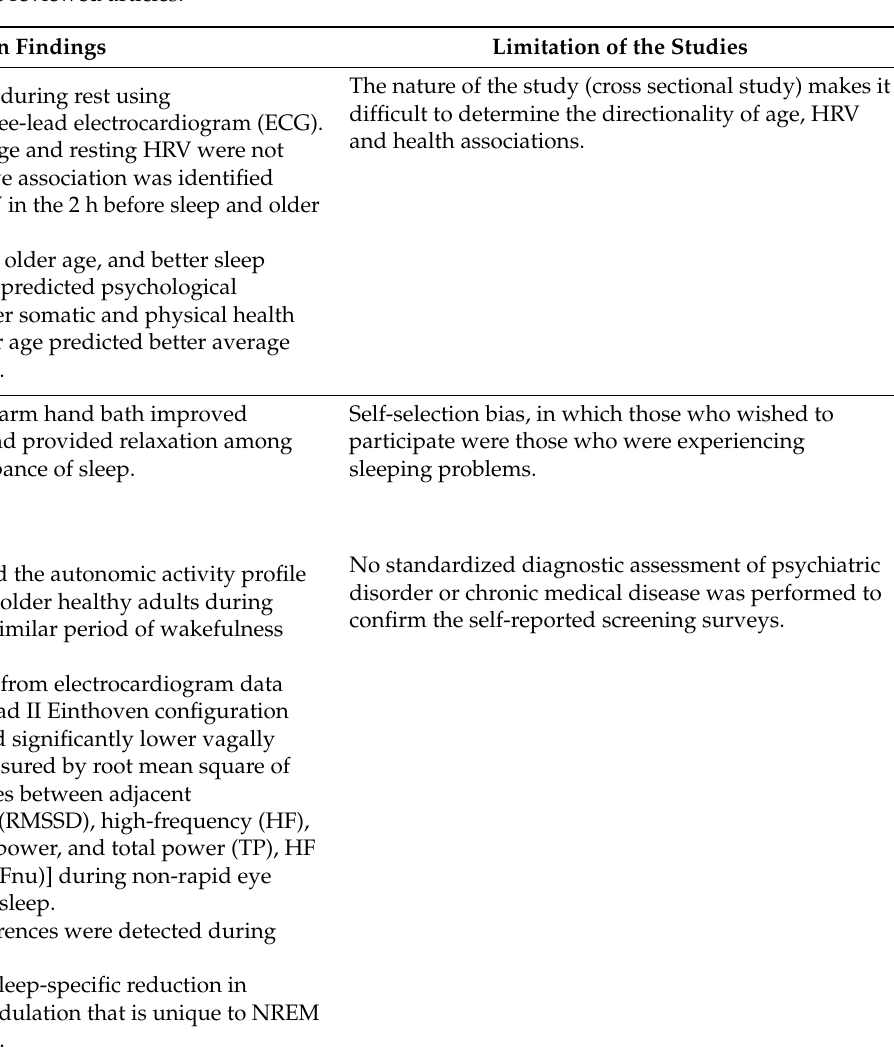
Table 1. The description of the reviewed